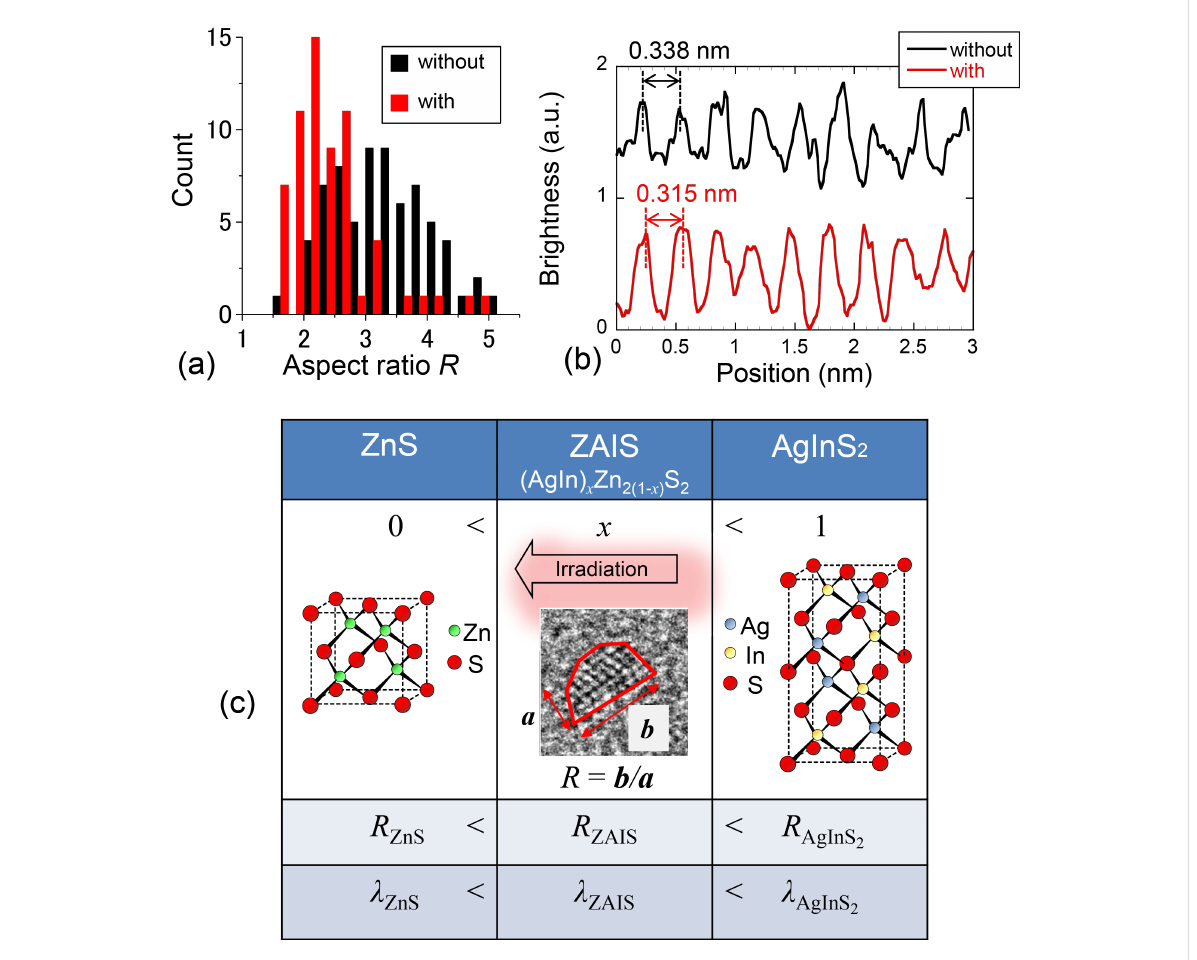
Figure 8: (a) Distribution of R among nanocrystals grown without and with 532 nm light (400 mW), for a growth time of t = 60 min. (b) Cross-sectional profiles of image brightness along the dashed white line in Figure 5b (without irradiation) and Figure 6b (with irradiation). (c) Schematic of the tran- sition of the crystal structure of ZnS and AgInS 2 depending on the